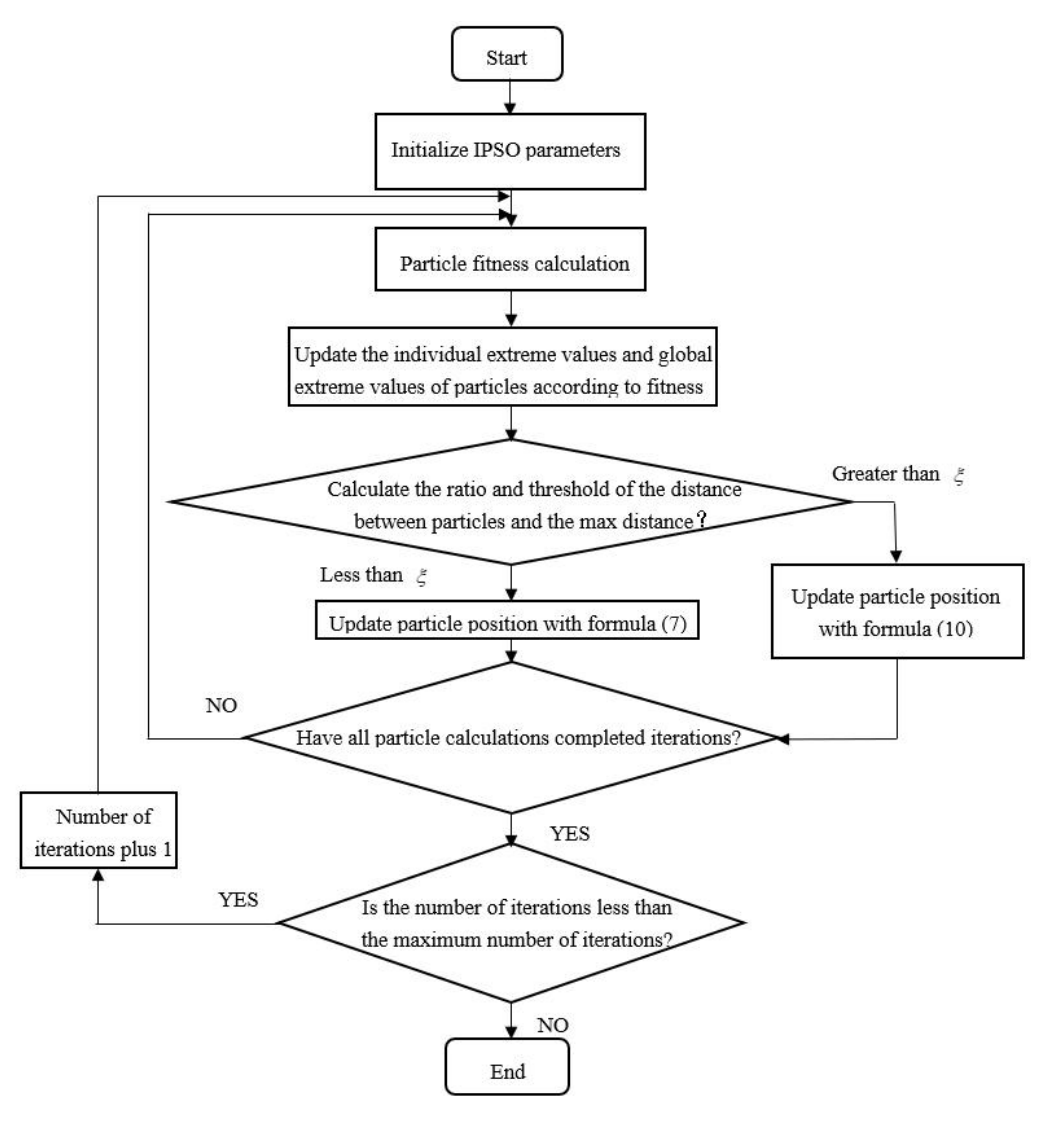
Figure 2. Procedure about IPSO-SVM algorithm.